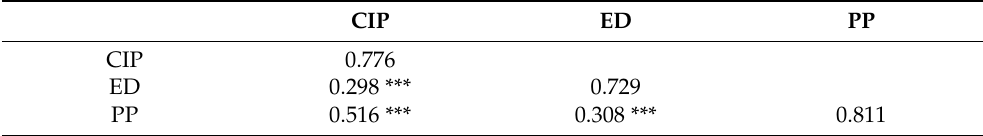
Table 10. Discriminant validity result of CFA. CIP ED